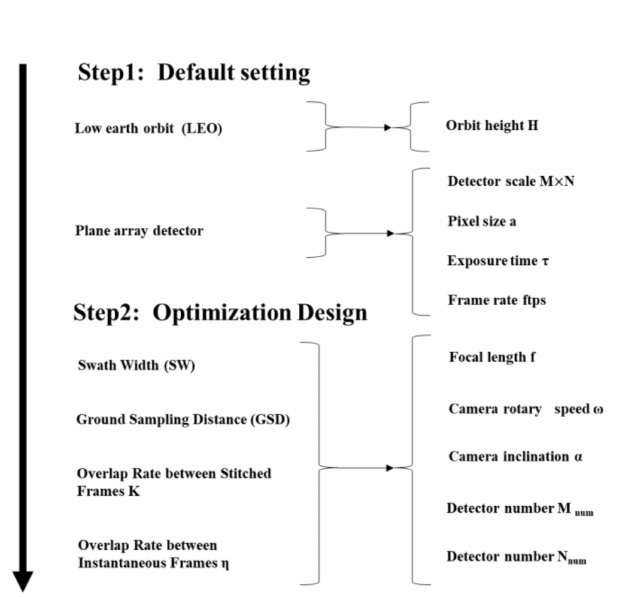
Figure 4. Diagram of the design